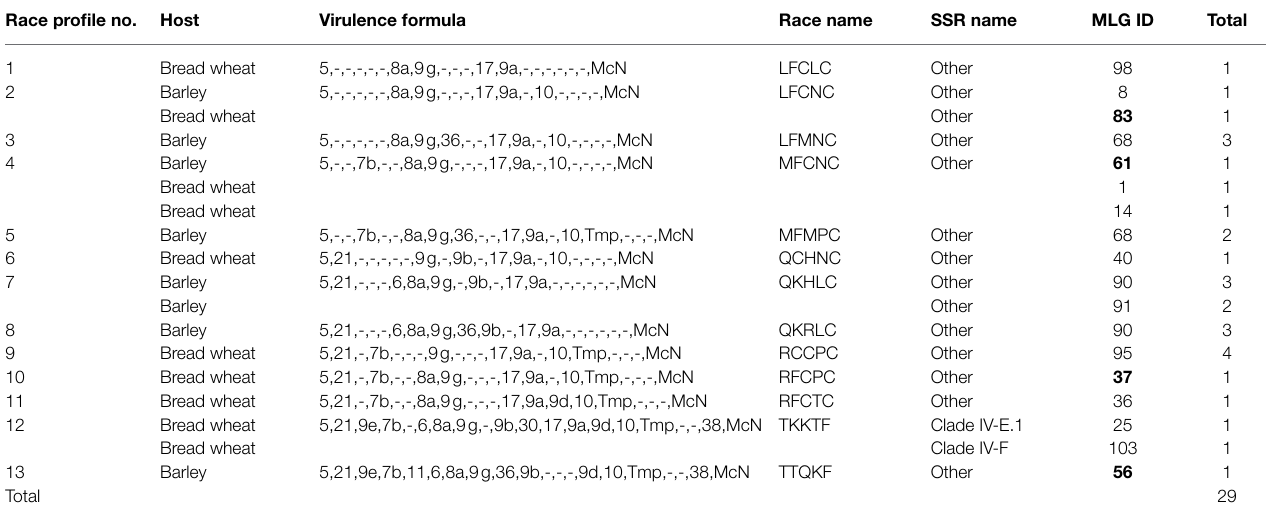
TABLE 6 | Virulence diversity of 13 races of P. graminis f. sp. tritici in Sweden 2017–2021. Race profile no.